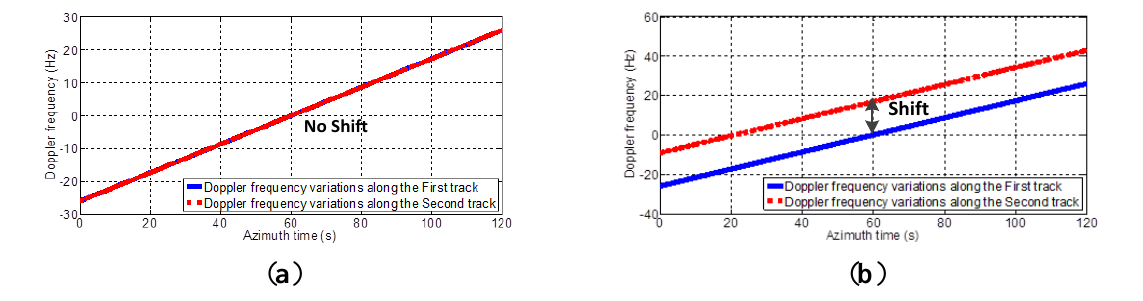
Figure 9. Doppler frequencies in two data acquisition methods: ( a ) ZDC data acquisition method; ( b ) OMRD data acquisition method.